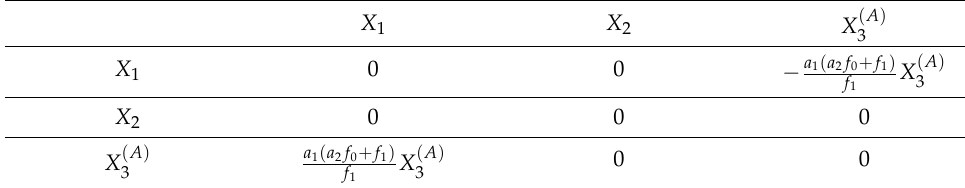
Table 2. Commutator table in the case